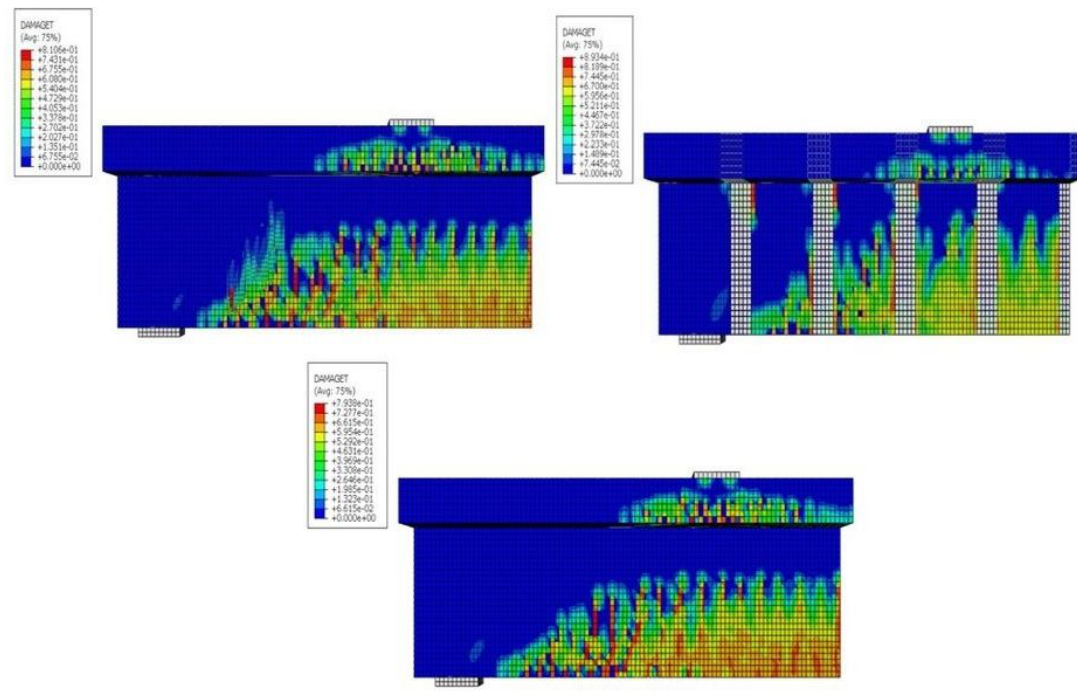
Figure 22: The numerical crack patterns of the specimens PB5 (top left), PB6 (top right) and PB7 (bottom